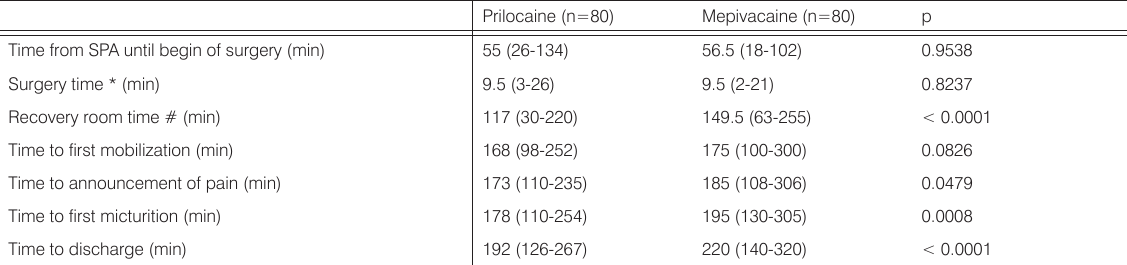
Table 3. Duration of anaesthesia and postoperative events. Values are median (range). *time from first incision to last surgical procedure; #time from entering PACU to attainment of an Aldrete score of ≥ 18, leading to discharge; SPA, spinal anaesthesia.